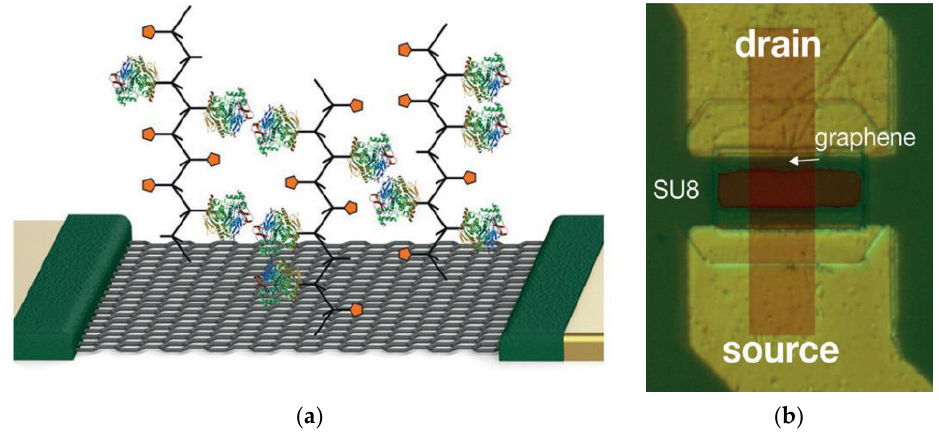
Figure 2. ( a ) Schematic representation of the enzyme functionalized GFET. ( b ) Micrograph of the GFET. Reprinted with permission from [36], Copyright 2014, American Chemical Society.